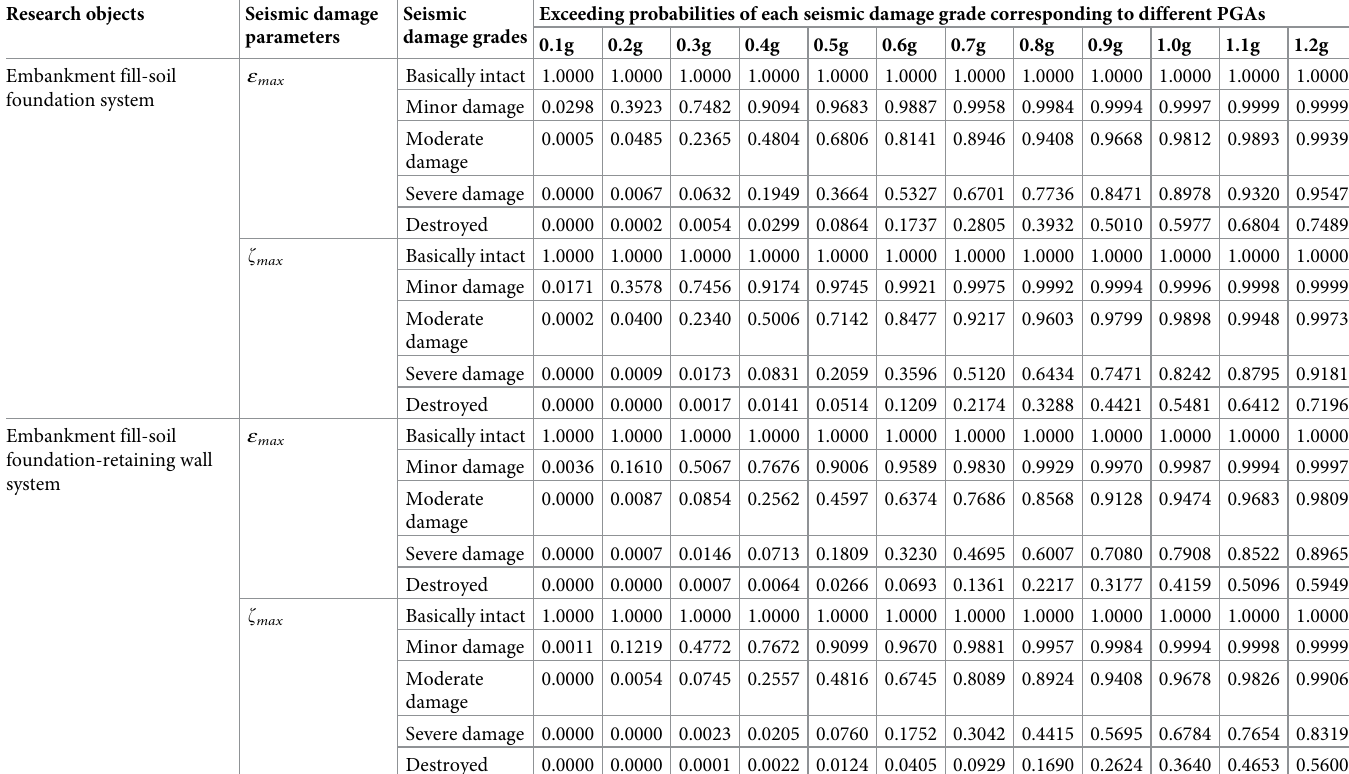
Table 7. Probabilities of each seismic damage grade corresponding to different PGAs. Research objects Seismic Exceeding probabilities of each seismic damage grade corresponding to different damage grades